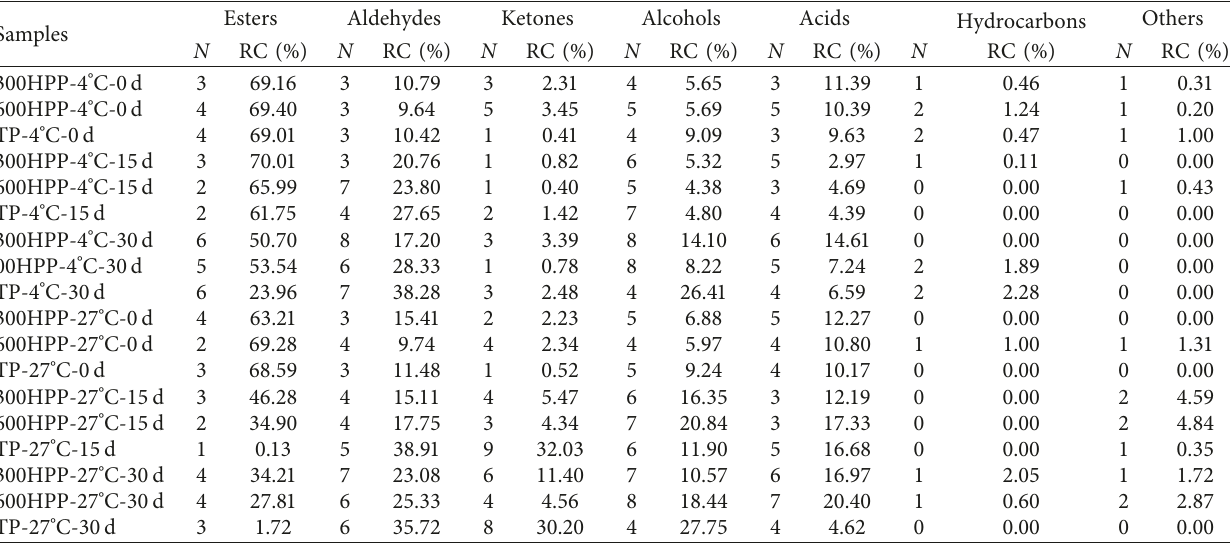
Table 4: The varieties and contents of volatile compounds in different beverage samples. Samples